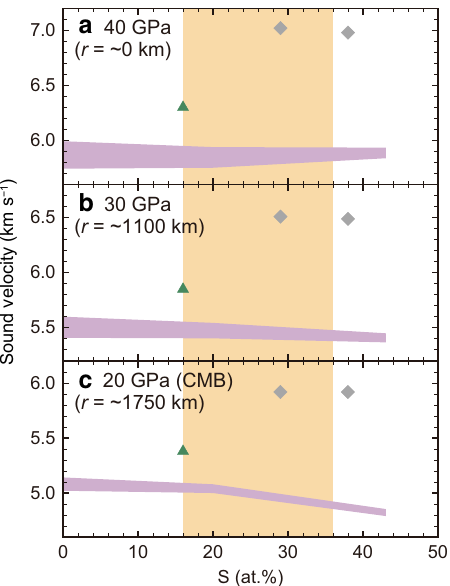
Fig. 4 Sound velocity of liquid Fe – S alloy as a function of sulfur content under Martian core conditions. ( a ) 40 GPa (Mars ’ center); ( b ) 30 GPa; ( c ) 20 GPa (Martian core-mantle boundary). Purple bands show the present estimates. Orange represents the sulfur content expected in the Martian core 4,5,22 – 24 . Green solid triangles denote V P measured for liquid Fe 84 C 16 26 . Gray diamonds denote V P for Fe 61 Ni 10 Si 29 and Fe 52 Ni 10 Si 38 calculated from ref. 27 . The radius, r , is based on ref. 2